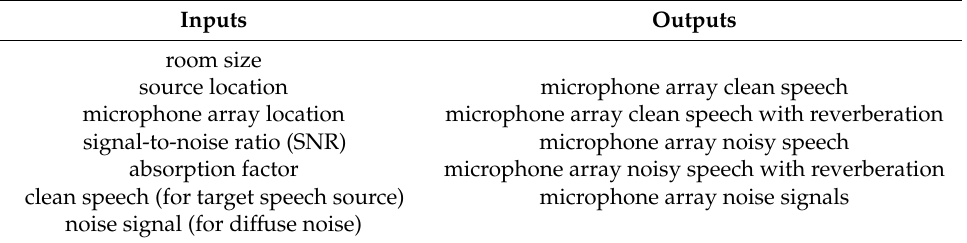
Table 1. The inputs and outputs of the MASS.